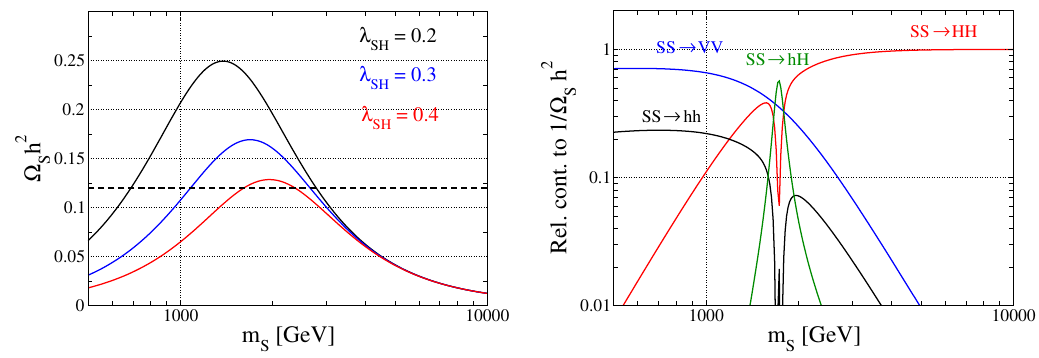
Figure 5 . Relic abundance of DM (left) and the relative contribution of each annihilation channel to (Ω S h 2 ) − 1 (right) as a function of the mass of DM m S in CP 2-2 with v φ = 3 TeV. The black, blue and red curve in the left panel show the case with λ SH = 0 . 2 , 0.3 and 0.4, respectively, while the right panel shows the case with λ SH = 0 . 3 . In the left panel, the horizontal dashed curve denotes the observed relic abundance Ω S h 2 ’ 0 . 12 at the Planck experiment